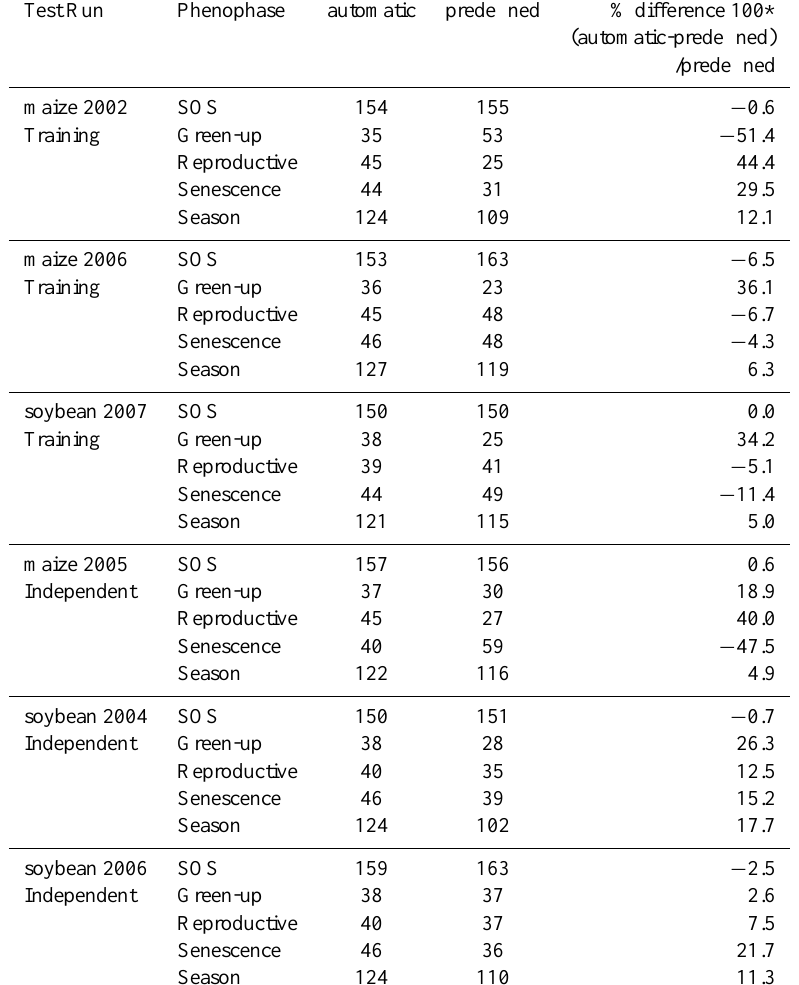
Table 4. Phenological transition dates estimated by automatic phenological control module compared with observed PTPs. Other phase controlling parameters are reported in Appendix Table